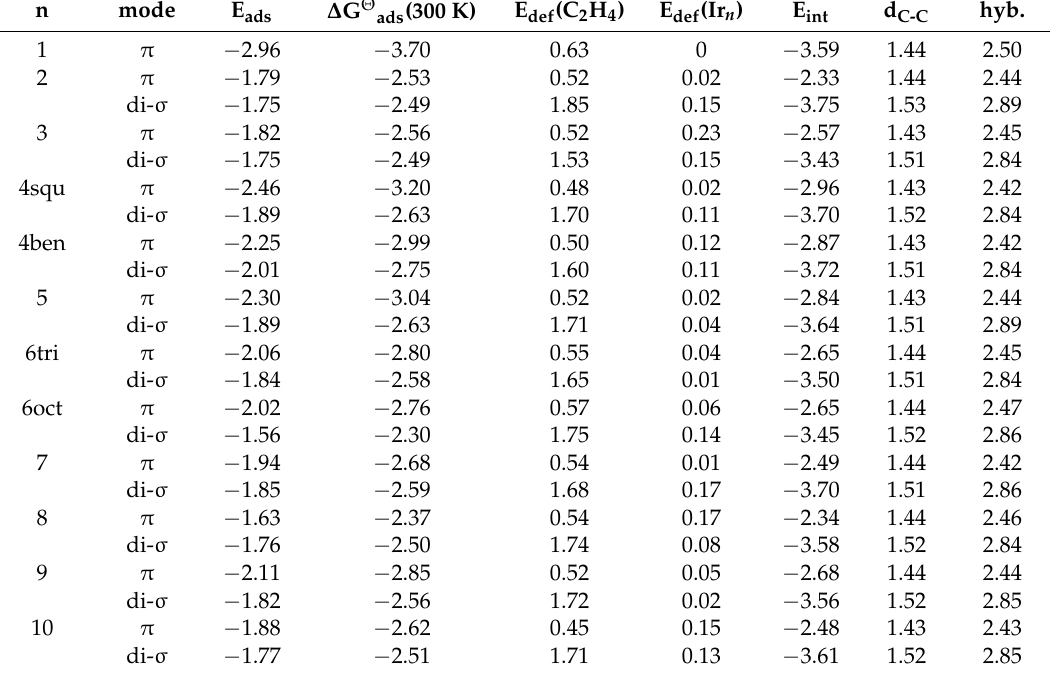
Table 1. Adsorption energy E ads (eV), standard adsorption Gibbs free energy at 300 K with the partial pressure of ethylene at 1atm ∆ G Θ ads (300 K) (eV), ethylene deformation energy E def (C 2 H 4 ) (eV), Ir n cluster deformation energy E def (Ir n ) (eV), interaction energy E int (eV), carbon–carbon bond